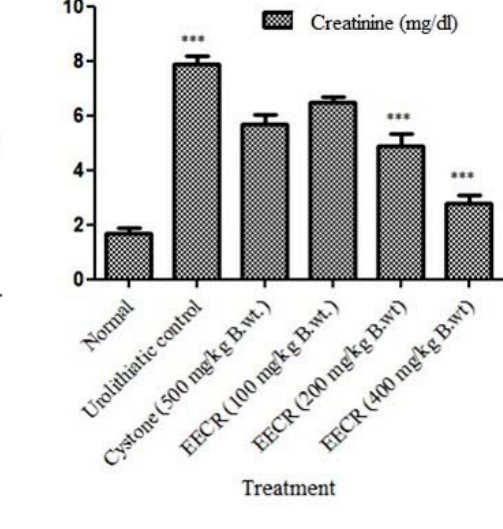
FIGURE 6 - Effect of EECR on urine creatine urolithiasis